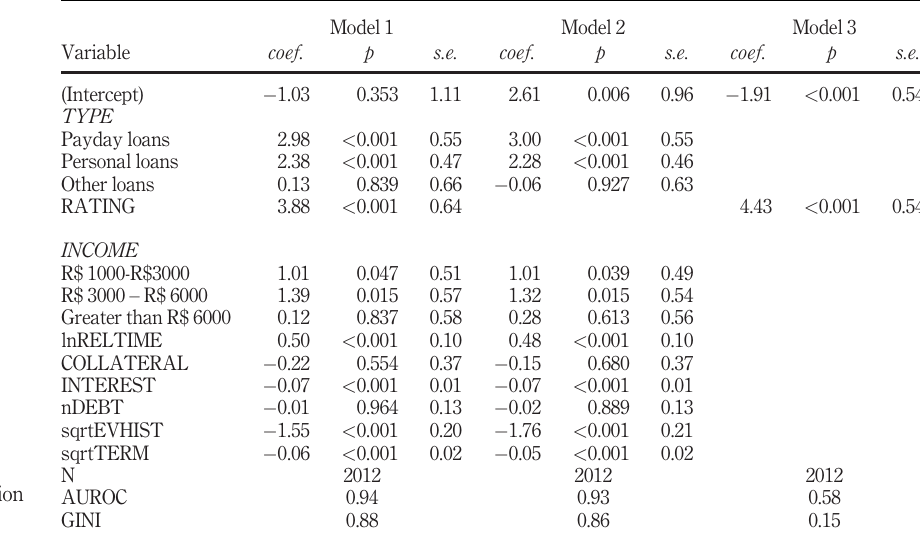
Table VI. Logistic regression